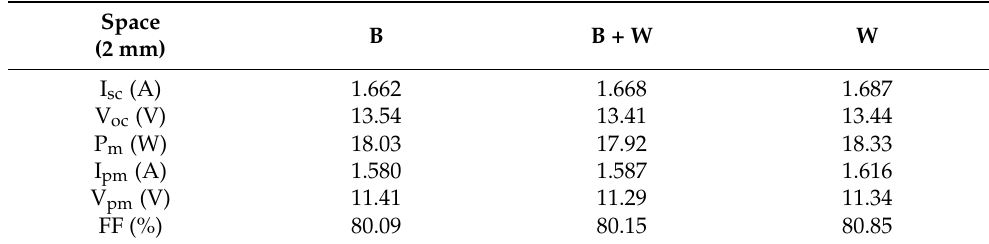
Table A4. The summary of shingled module operating test with various backsheets with 2 mm gap space.